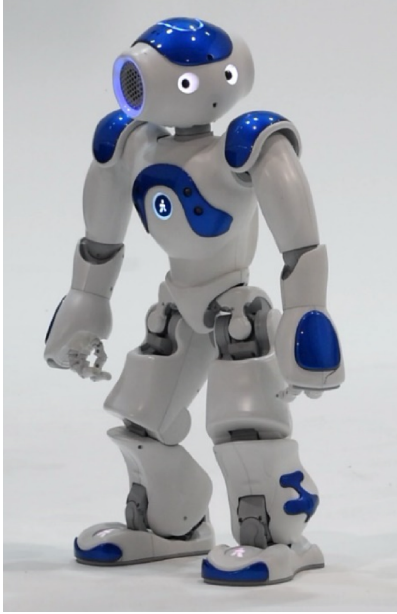
Figure 1. Humanoid robot